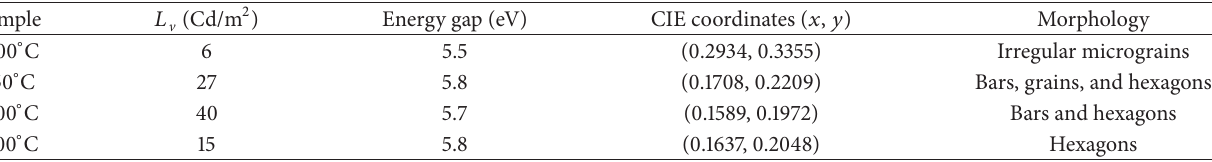
Table 1: Summary of the luminance values, energy band- gap estimated values, CIE coordinate, and morphology of the samples annealed at different temperatures.